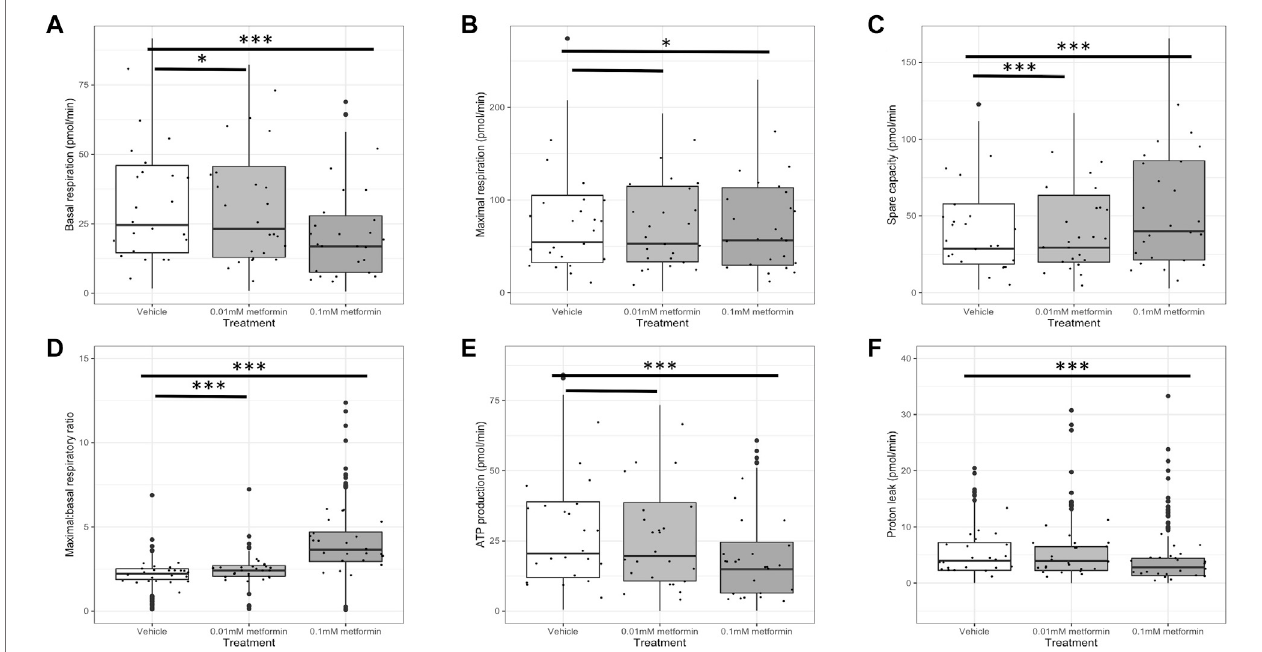
FIGURE 3 | Respiratory parameters in trophoblasts: metformin (0.01 mM or 0.1 mM) versus control ( n = 24 per group). Values are derived from parameter calculationscomparingtheoxygenconsumptionrate(OCR)undervariousconditionsandexpressedaspmolO 2 consumedperminute.Anexampleofthefullstresstest pro fi les obtained is presented as Supplementary Figure S1 . (A) Basal respiration, de fi ned as O 2 consumption when respiring under normal conditions with non- mitochondrial O 2 consumption subtracted; (B) Maximal respiration, de fi ned as maximal respiratory rate measured following addition of an uncoupling agent with non-mitochondrial O 2 consumption subtracted; (C) Spare respiratory capacity, de fi ned asmaximal respiration with basalrespiration subtracted; (D) Ratio ofmaximal to basal respiratory capacity; (E) mitochondrial-dependent ATP production, de fi ned as O 2 consumption when respiring under normal conditions minus the rate after addition of an ATP synthase inhibitor; (F) Proton leak, de fi ned as the minimal rate of respiration after addition of an ATP synthase inhibitor with non-mitochondrial O 2 consumption subtracted. p values are derived from mixed hierarchal regression models with fi xed effect for treatment groups and random effect for placenta-of-origin. *** p < 0.001, * p < 0.05, line only p < 0.1.